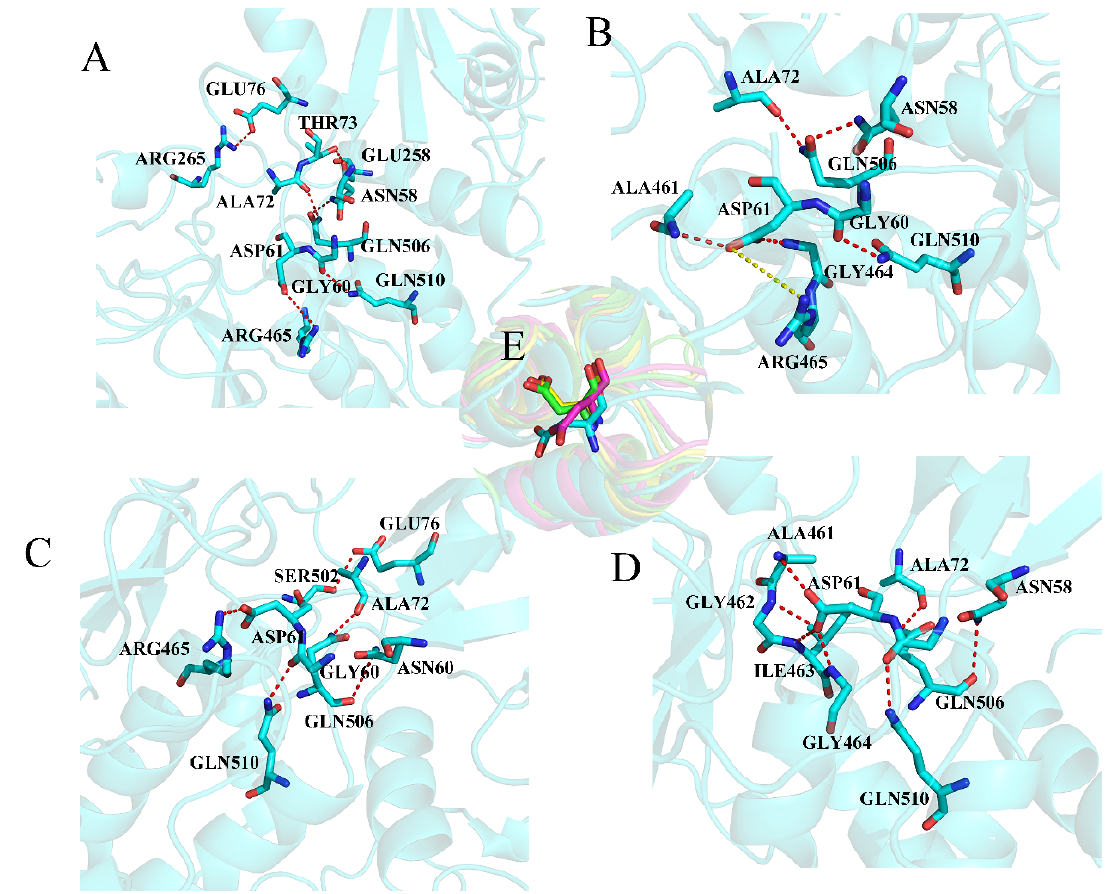
Figure 5. The hydrogen bonds between the N-SH2 domain and the PTP domain in the systems SHP2 ( A ), EPIYA-D-N ( B ), EPIYA-C-N ( C ), and EPIYA-C-DUAL ( D ). The red dotted line means that there is a hydrogen bond between the two residues, and the yellow dotted line means that the distance is too great to form a hydrogen bond (more than 3.5Å). The key residue ASP61 is shown separately for the systems SHP2 (magenta), EPIYA-D-N (green), EPIYA-C-N (blue), and EPIYA-C-DUAL (yellow) ( E ).